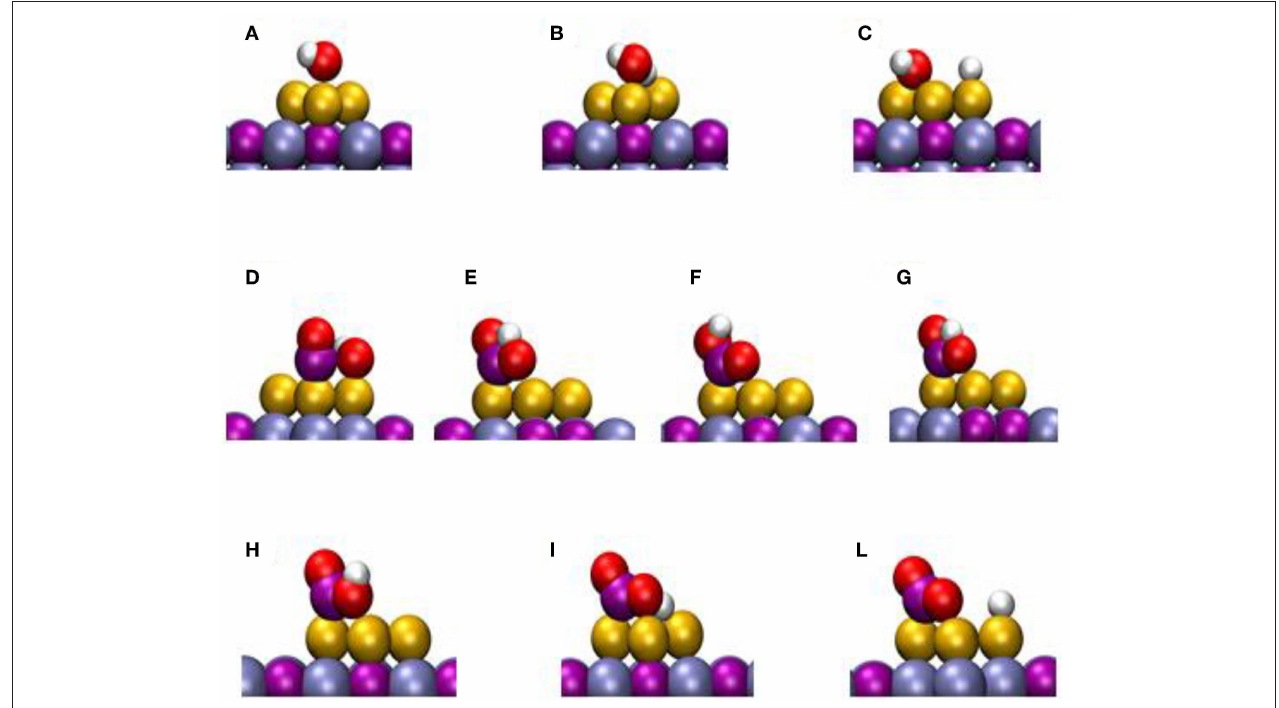
FIGURE 7 | Calculated structures for different intermediates of the WTS reaction on Au/TiC(001). The labels refer to specify states in Figure 6 . Reproduced with permission from Rodriguez et al. (2014), copyright 2014 by